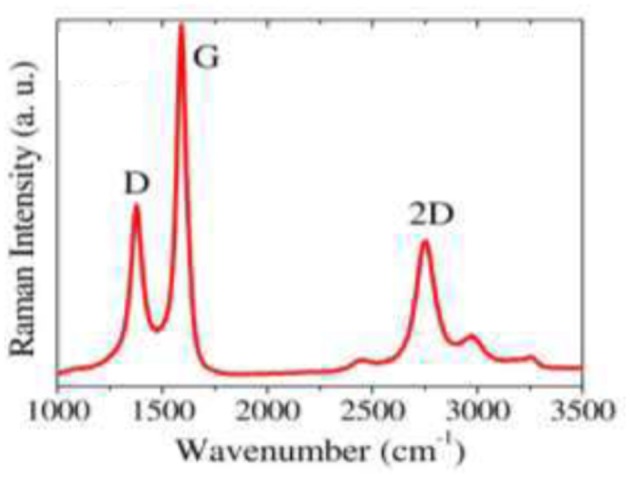
Raman spectrum at 442 nm of Ni/a-C(20 nm)/Si after thermal annealing at 780°C ([Reproduced from Tite et al. (2014) with permission of AlP Publishing].